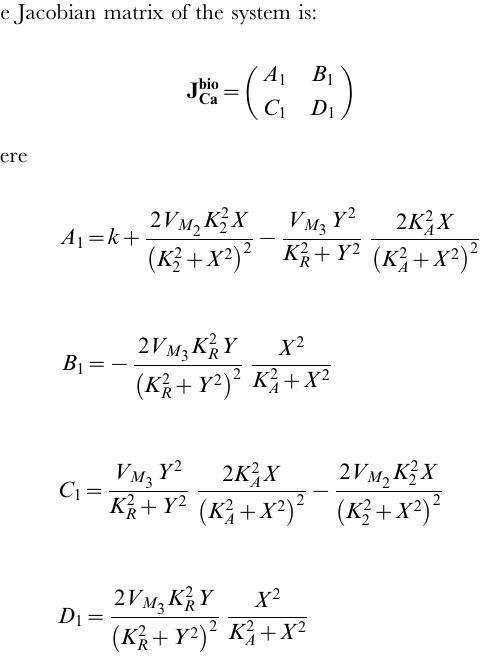
Table 2. Chemical And Electrical Equations Of The Gene-Protein System Model, Codified By (2), (35) & (36).